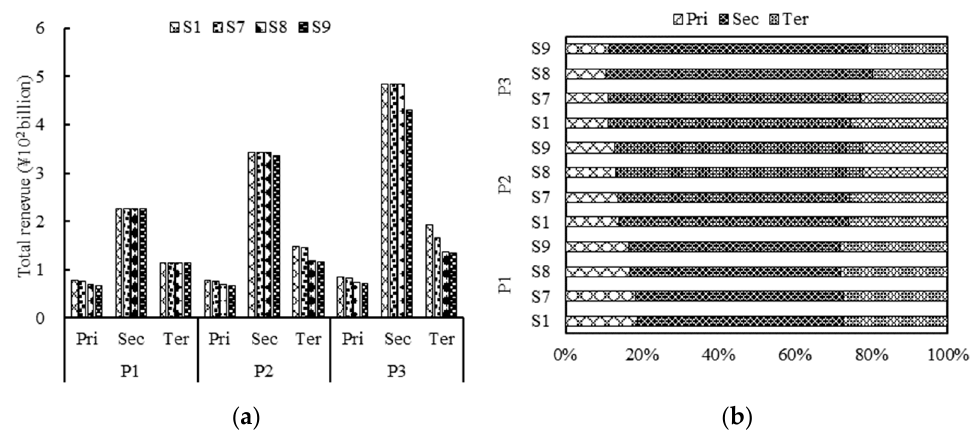
Figure 4. Industry scale for three planning periods under four scenarios: S1, S7, S8 and S9. ( a ) Comparisons of the industry’s output. ( b ) Breakdown of total revenue.